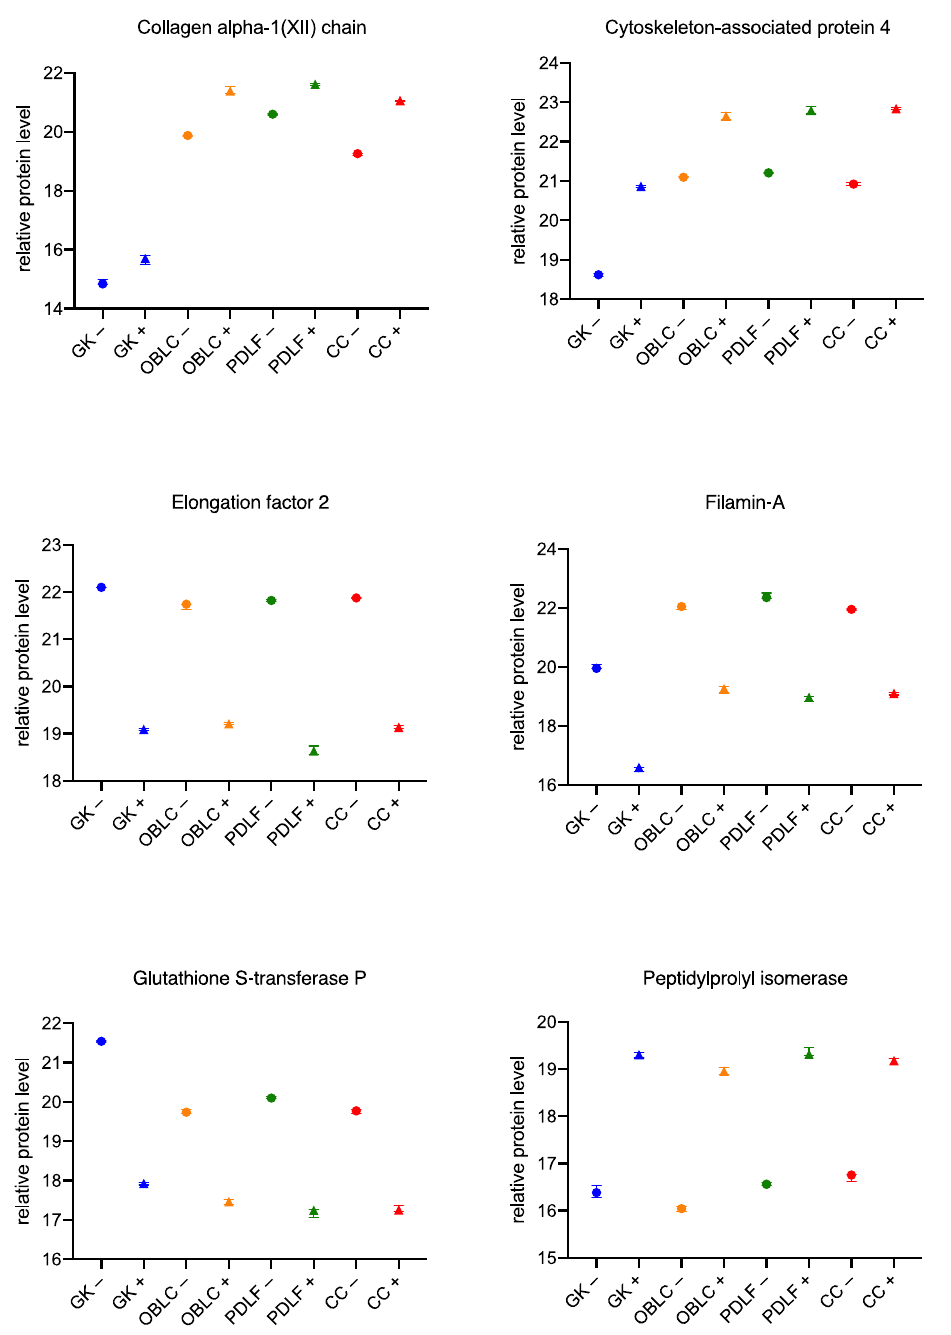
Figure 7. Significant concordances in the behavior of individual cells during culture with bacteria Part 1. Protein peak areas were transformed with a log2 scale, and bacterial conditions were compared pairwise with standard conditions using a Student’s t -test ( p < 0.05) and Benjamini-Hochberg correction for multiple testing. “+” indicates culture with bacteria; “–” indicates culture without bacteria.